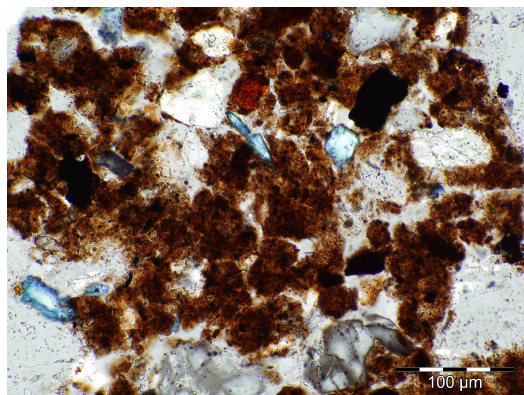
Figure 4. Distribution pattern of organic aggregates in a thin sec- tion of the Aan of Valenakker (40–50cm). In the fabric of the ag- gregates are charcoal particles visible.